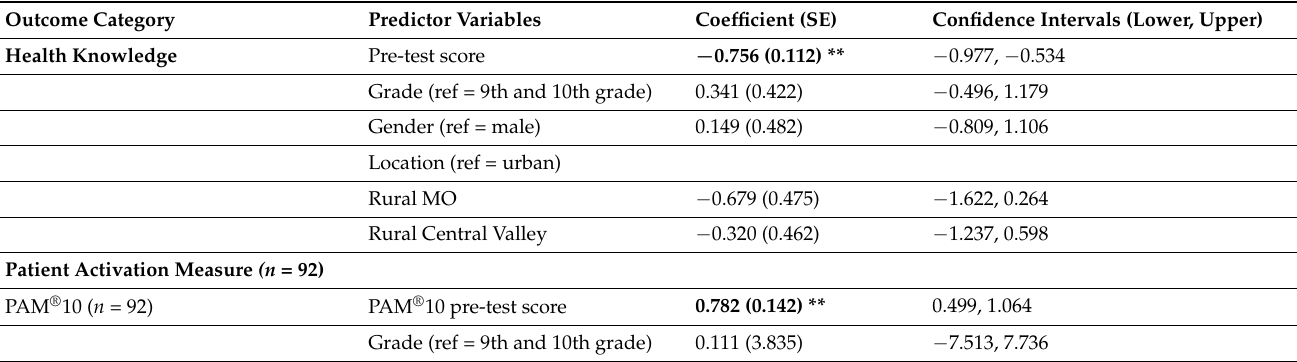
Table 4. Linear regression models for select outcomes in San Jose, CA; Lawrence County, MO; and Central Valley, CA; 2020–21. ( n =